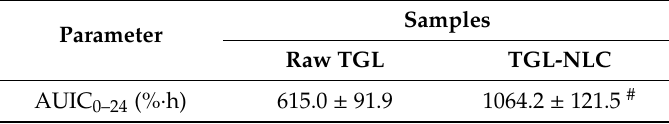
Table S1: Coe ffi cient equations of responses according to the level of factors, Table S2: Analysis of variance for model of particle size (Y 1 ), Table S3: Analysis of variance for model of polydispersity index (Y 2 ), Table S4: Analysis of variance for model of encapsulation e ffi ciency (Y 3